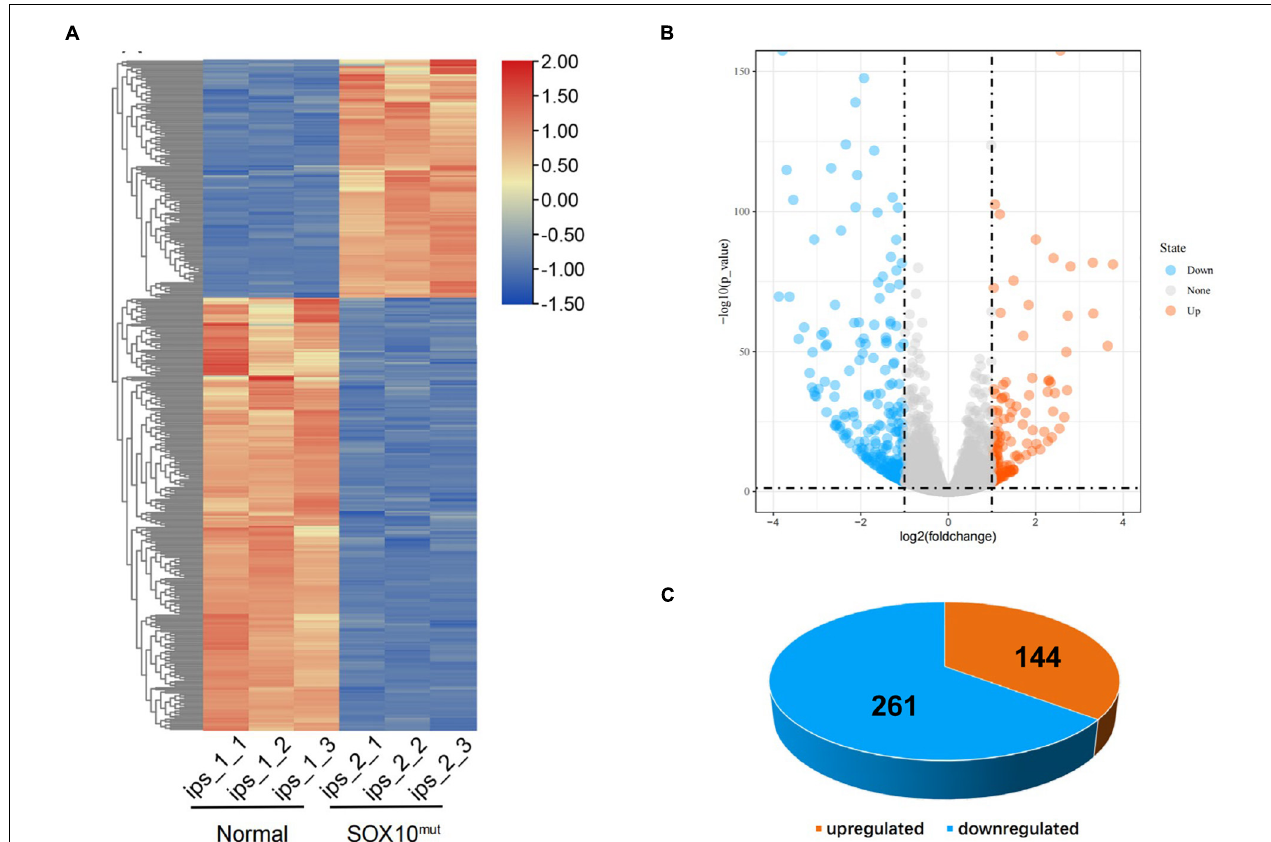
FIGURE 4 | Differentially expressed genes in SOX10 mutant iPSCs. (A) The heatmap showed hierarchical clustering analysis of DEGs in SOX10 mutant iPSCs. The FPKM values of DEGs were normalized by scale function and compared between the SOX10 mutant iPSCs and normal control. Red and blue indicate genes with high and low expression levels, respectively. (B) Volcano plot showing the expression change of each gene and their significance. Red dots represent the expression of genes in SOX10 mutant iPSCs significantly up-regulated compared to normal control. Blue dots represent the expression of genes in SOX10 mutant iPSCs significantly down-regulated compared to normal control. (C) Of the DEGs, 144 genes were up-regulated and 261 genes were down-regulated.